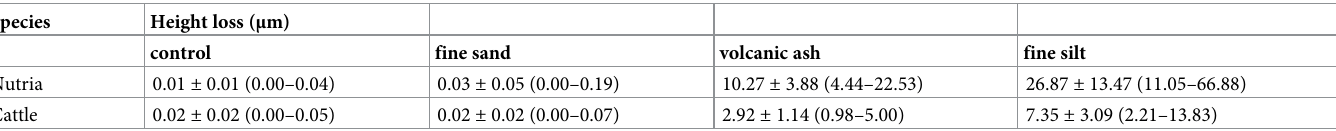
Table 2. Mean ± standard deviation (range) height loss incisor enamel of nutria ( Myocastor coypus ) and cattle ( Bos primigenius taurus ) in a standardized brush test with different treatments (n = 24 per treatment and species, except nutria fine silt n = 23).